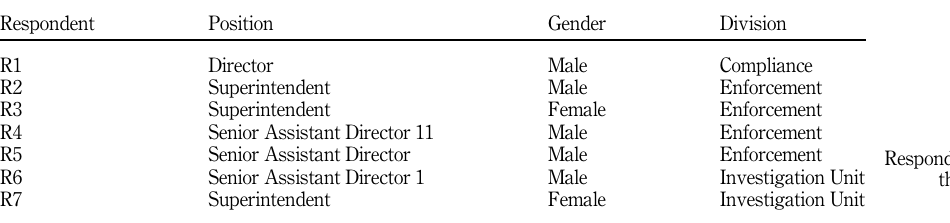
Table 1. Respondent profile